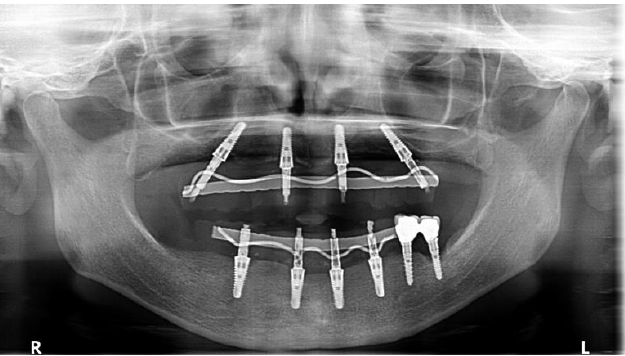
Figure 3. Panoramic view at 7-year after loading. Both protheses were replaced by monolithic ones in the prosthesis recall program.